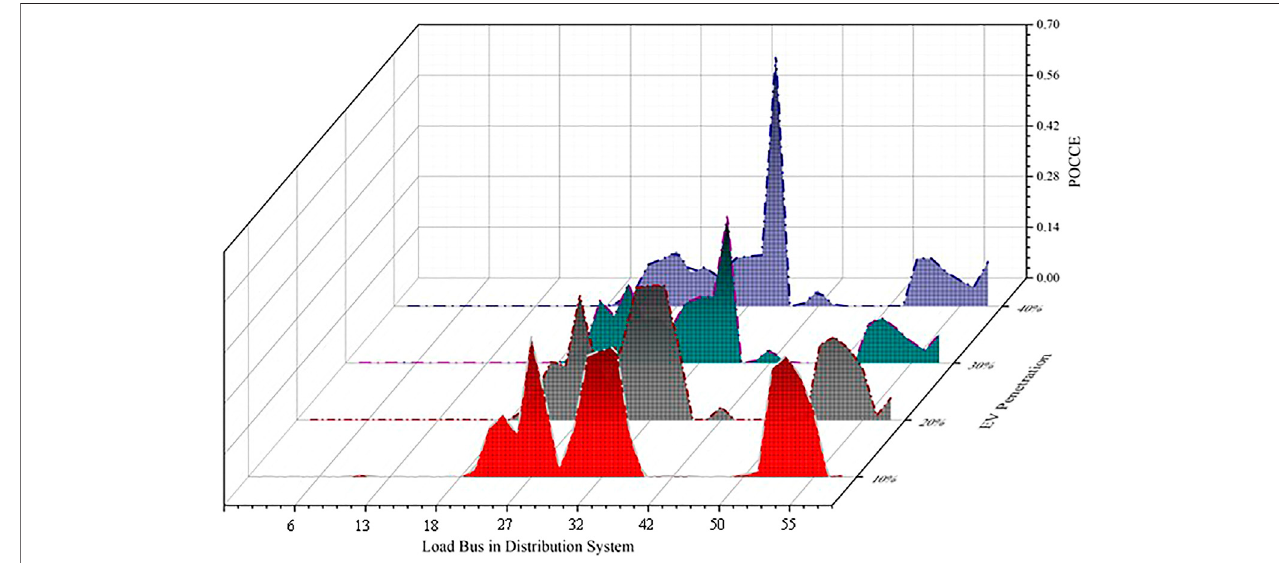
FIGURE 8 | Reliability index POCCE based different EV penetration.